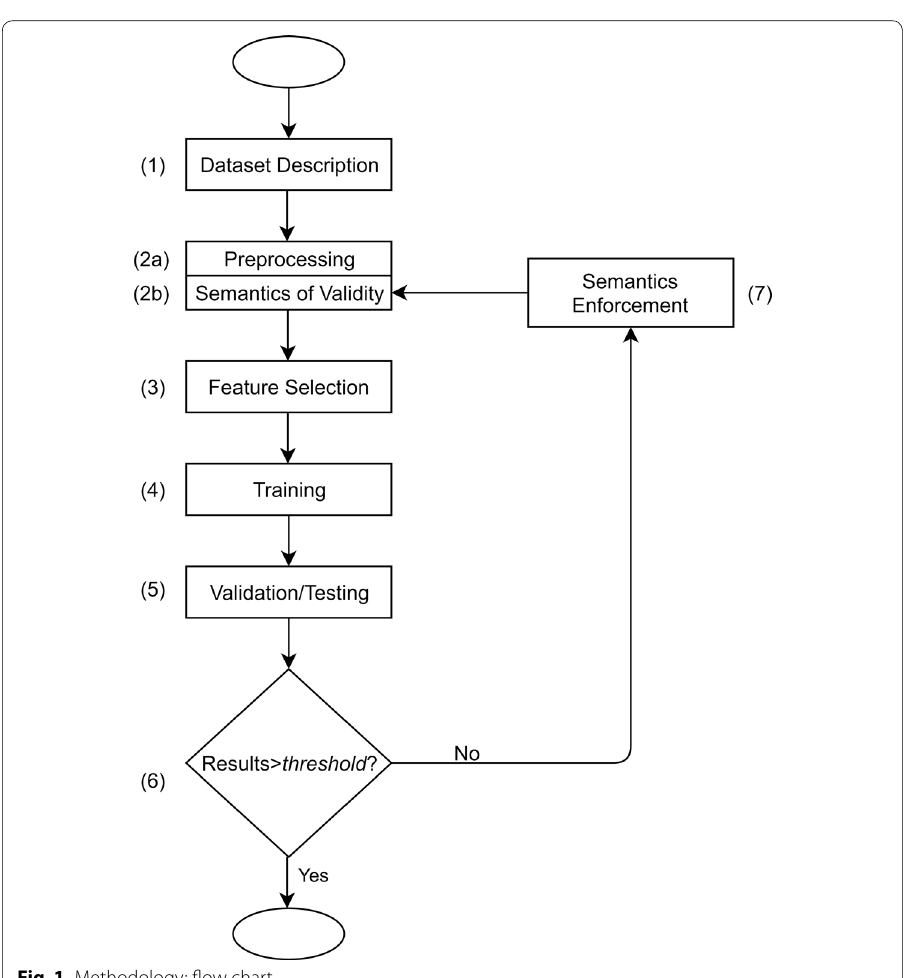
Fig. 1 Methodology: flow